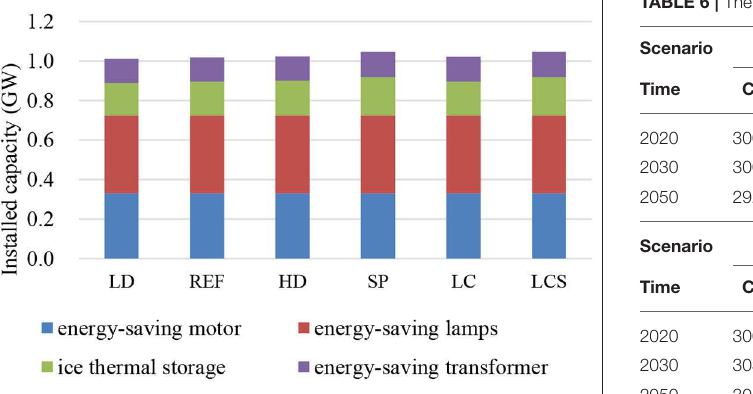
TABLE 6 | The emissions of CO 2 , SO 2 , and NO x in six scenarios (in million